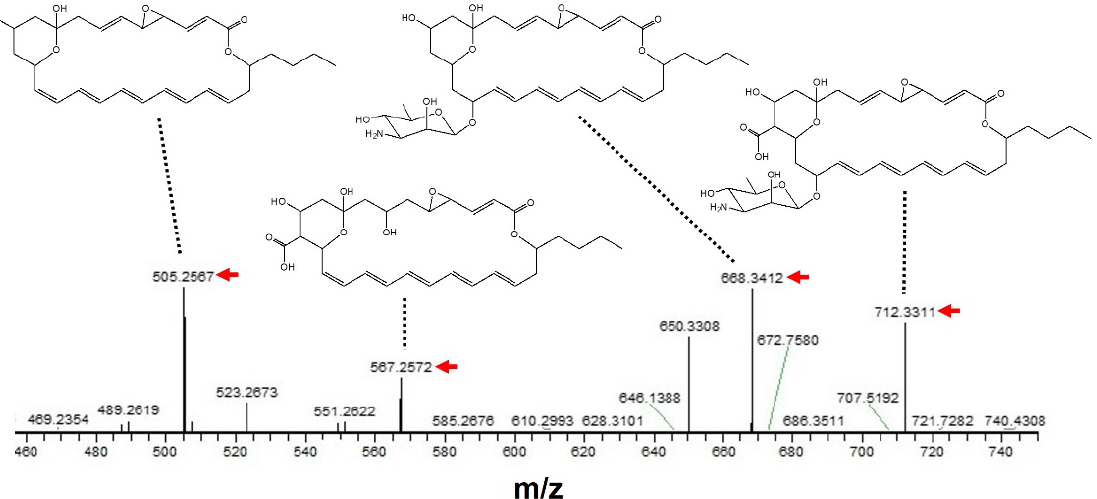
Figure 4. MS/MS analysis of an antifungal compound isolated from S. achromogenes subsp. strepto- zoticus NBRC14001. A peak having m / z = 730.3416 [M + Na] + was used as a precursor ion. A red arrow indicates the m / z of each fragment